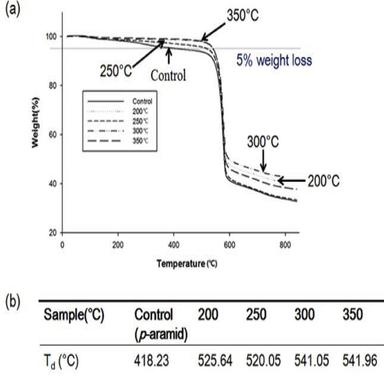
(a) TGA thermogram of PI / p-aramid filaments at different temperatures (°C), and (b) thermal degration temperature (Td) of PI / p-aramid filaments at different temperatures (°C). Here, the final curing time was 10 min.